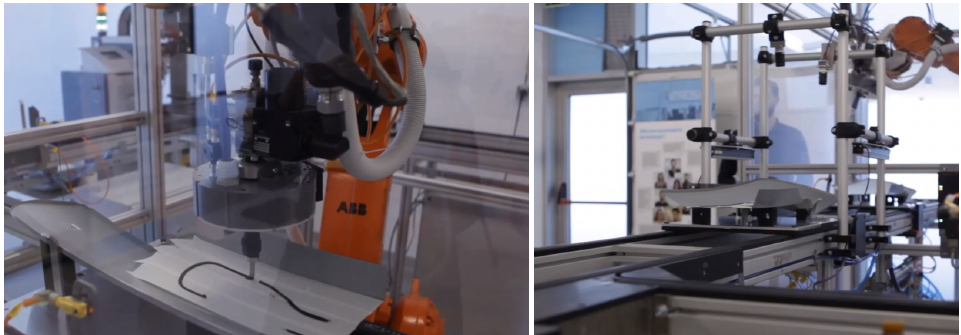
Figure 1. ( left ) The structural adhesive application station showing a discontinuity defect. ( right ) The quality inspection station